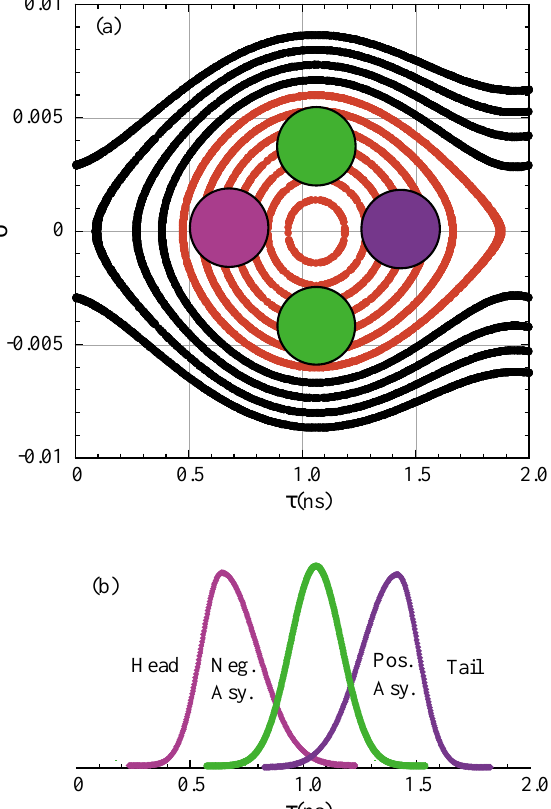
FIG. 3. (Color) (a) A bunch experiencing a large amplitude oscillation in longitudinal phase space and (b) a temporal pro- jection of the bunch at three different displacements in longitu- dinal phase space. The temporal bunch distribution is symmetric or asymmetric depending on its position in longitudinal phase